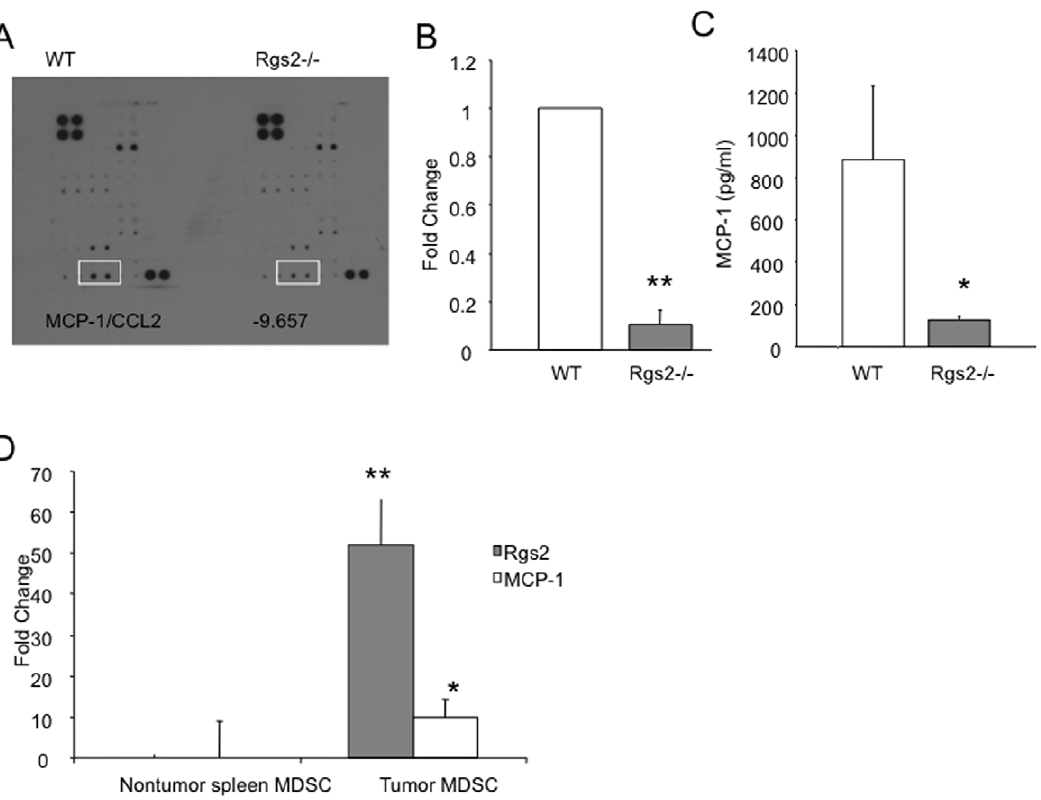
Figure 8. Rgs2 regulates MCP-1 expression in MDSCs. MDSCs were isolated from 3LL tumor tissues of wild type or Rgs2 2 / 2 mice by magnetic sorting after digestion of the tissues with hyaluronidase and collagenase. (A) Protein lysates from the isolated cells were analyzed using a cytokine array. Each cytokine is detected in duplicate, and intensity was determined using ImageJ software. Positive controls provided on the array were used for normalization. This experiment was performed twice. (B) RNA was extracted from the isolated MDSCs, and analyzed by real time PCR. Beta-actin was used as an internal control. This experiment was repeated 3 times. (C) MDSCs were isolated from tumors of wild type and Rgs2 null mice, and cultured for 48 hours. Culture medium was assayed for MCP-1 protein by ELISA. This experiment was performed in duplicate and repeated 3 times. * p , 0.05, ** p , 0.00005. (D) MDSCs were isolated from normal spleen and 3LL tumor tissues of wild type mice. Rgs2 and MCP-1 levels were measured by real time PCR. Beta-actin was used as an internal control. This experiment was repeated 2 times. * p , 0.05, ** p ,